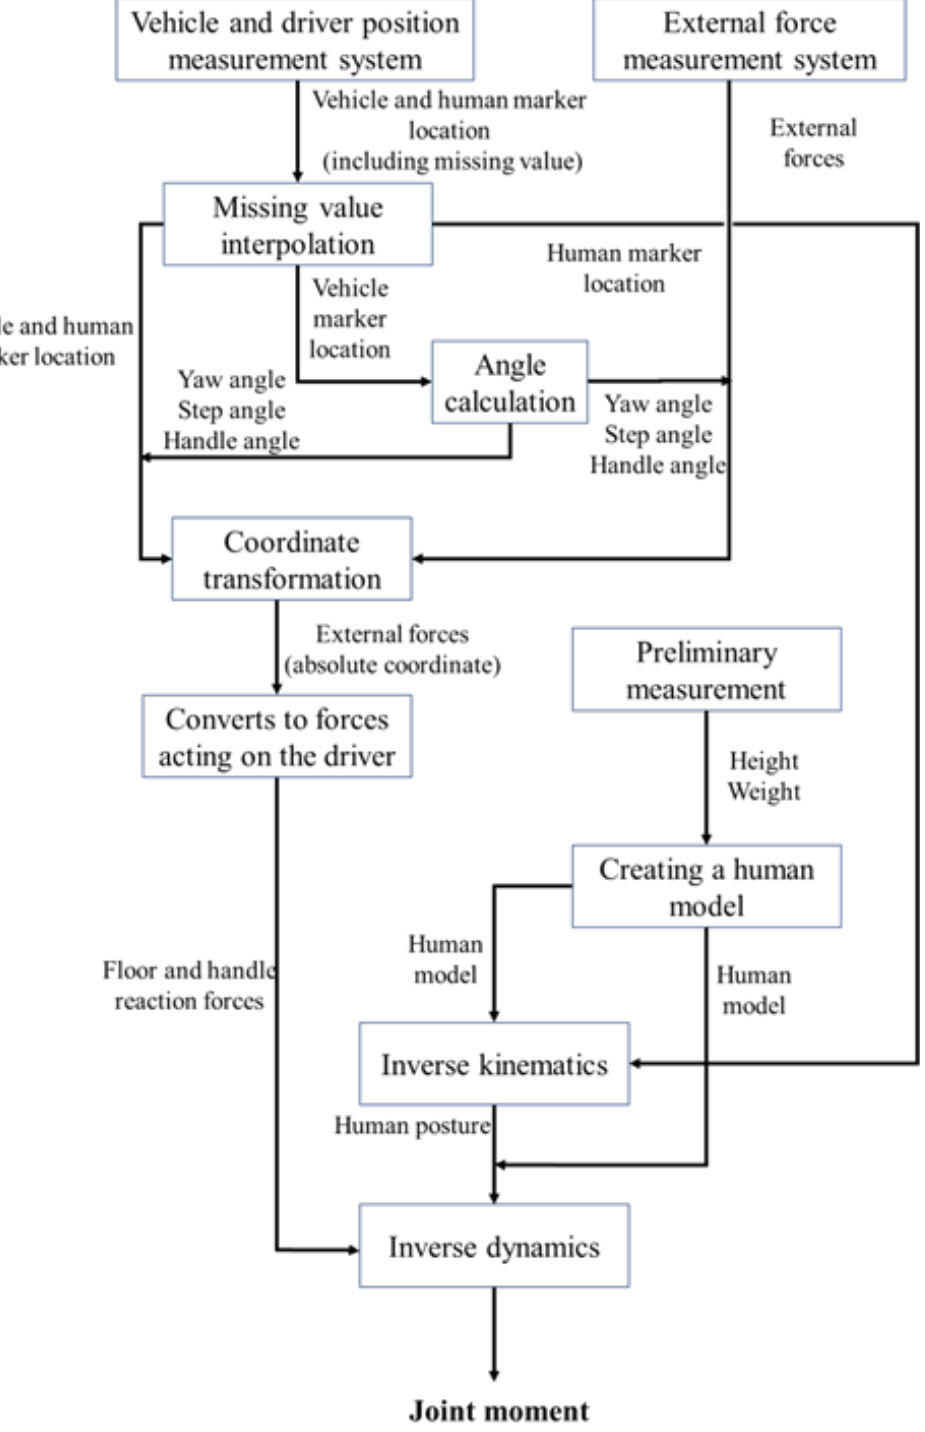
Figure 15. Data processing flow for determining joint moments.